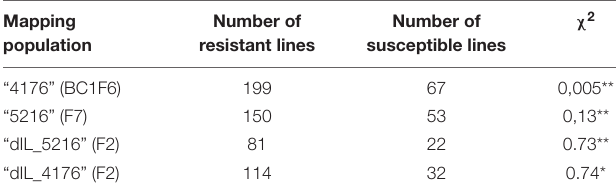
TABLE 2 | Phenotypic segregation of powdery mildew resistance in each of 2HS IL mapping populations. Mapping